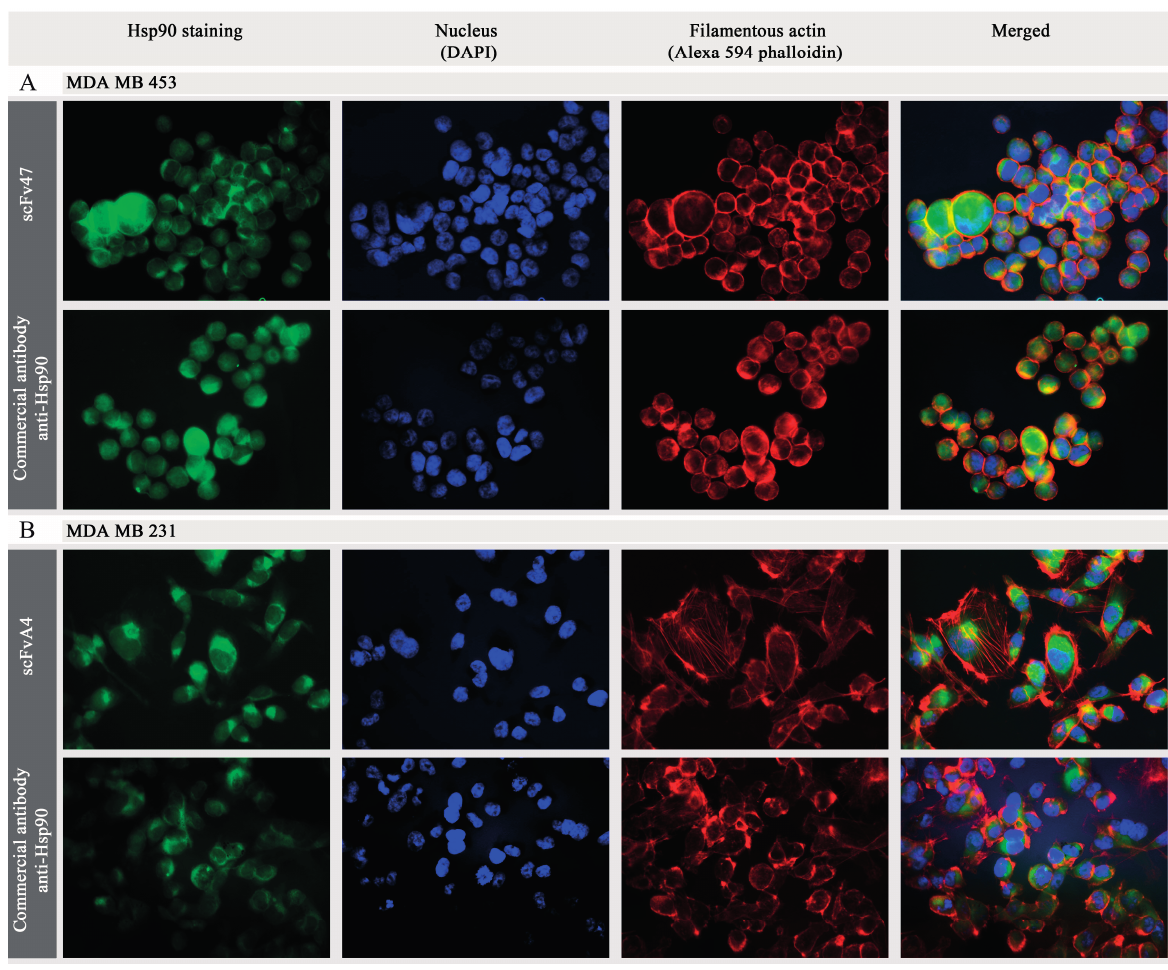
Figure 3. The immunofluorescence detection of intracellular Hsp90 in fixed and permeabilized. ( A ) MDA MB 453 cell line; and ( B ) MDA MB 231 cell